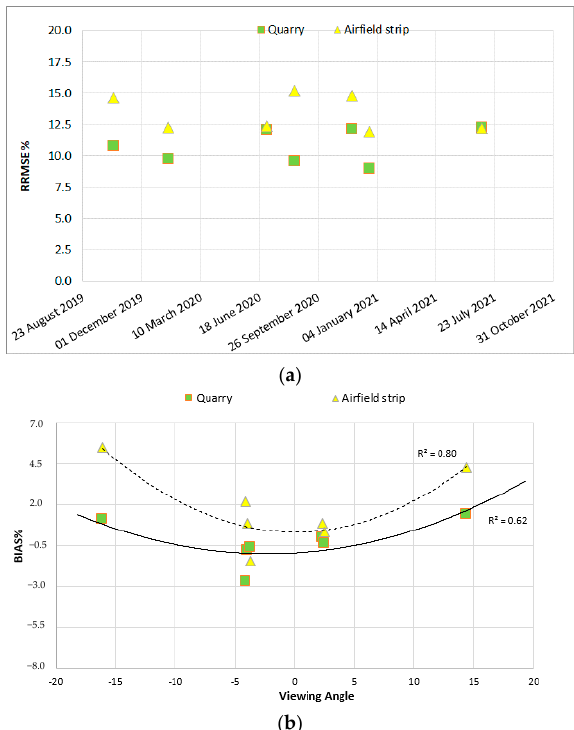
Figure 4. ( a ) RRMSE vs. dates and ( b ) roll angle vs. BIAS plots for the quarry (squares) and meadow airfield strip (triangles) targets during the PRISMA acquisitions.